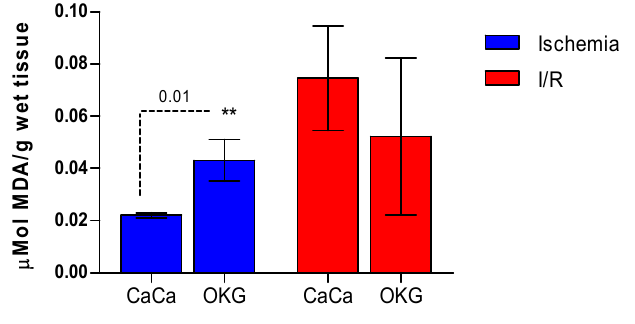
FIGURE 7 - Thiobarbituric acid-reactive substances levels (micromoles of malondialdehyde per gram of fresh tissue) in small intestine samples from CaCa and OKG-pretreated rats. Bars represent mean±SD of ischemia (blue bars) and reperfusion (red bars) groups at the end of the ischemia (30 min) and reperfusion (30 min). TBARS levels in OKG treated rats were greater than in CaCa-treated rats by Student´s t